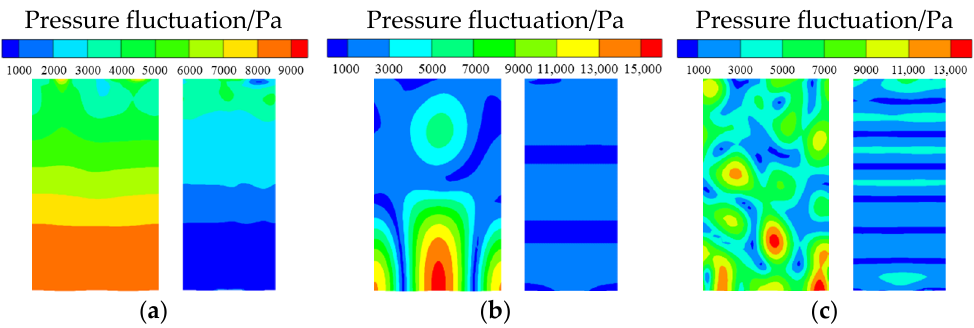
Figure 5. Pressure fluctuation on the tube surface: ( a ) 8 EO, 1600 Hz; ( b ) 36 EO, 7200 Hz; ( c ) 80 EO, 16,000 Hz.